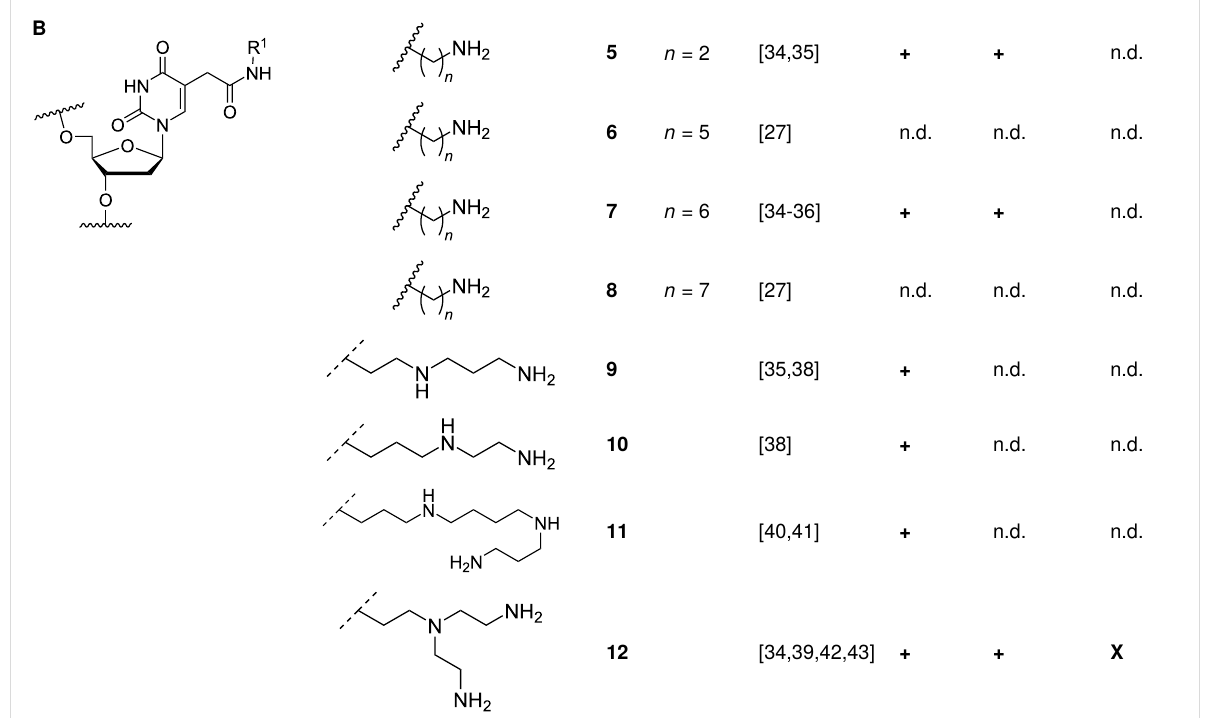
Table 1: Amine-functionalized groups on the nucleobase. a (continued)